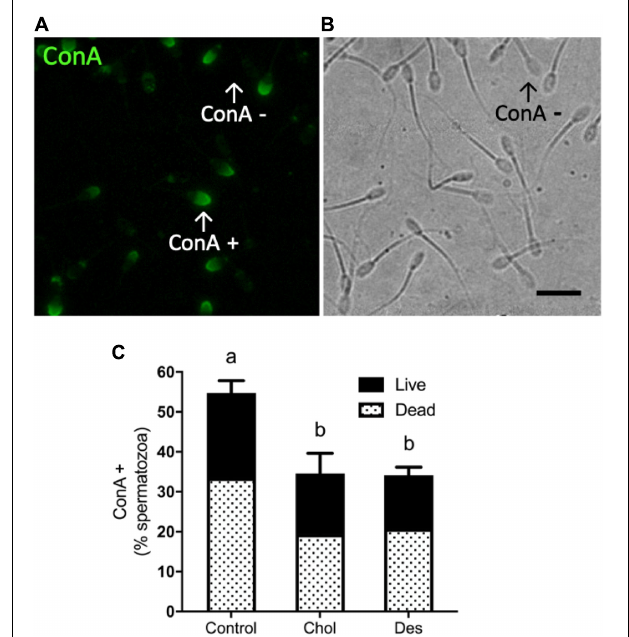
cryopreservation (A) Representative fluorescence image of cryopreserved ram spermatozoa incubated with FITC-Concanavalin A (ConA) showing stained cells (ConA+). (B) Bright field image. Scale bar represents 20 µ m. Arrows indicate ConA + and ConA − spermatic cells in counterpart images. (C) Percentage of ConA + ram spermatozoa after thawing showing the normalized percentages of live/dead spermatozoa. Stacked bars represent the mean values ± SEM ( N = 5). Data were analyzed using Generalized Linear Mixed Models (GLMM) with Binomial family. The different letters (a, b) indicate significant differences ( p <